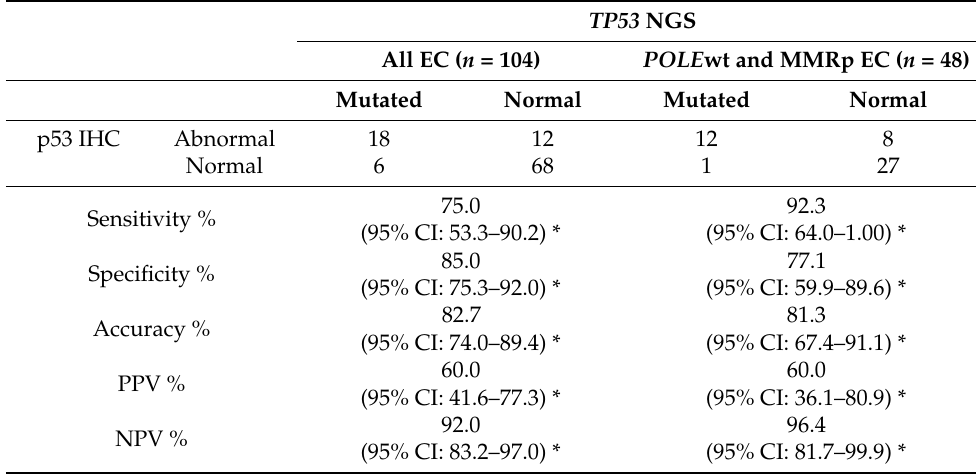
Table 5. Agreement between p53 IHC and TP53 NGS.